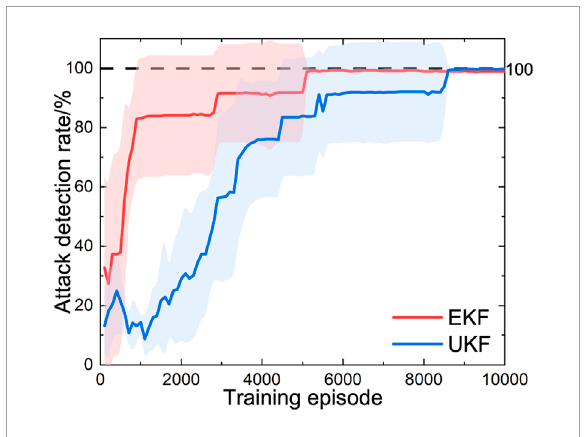
FIGURE 9 Attack detection rate against the hybrid